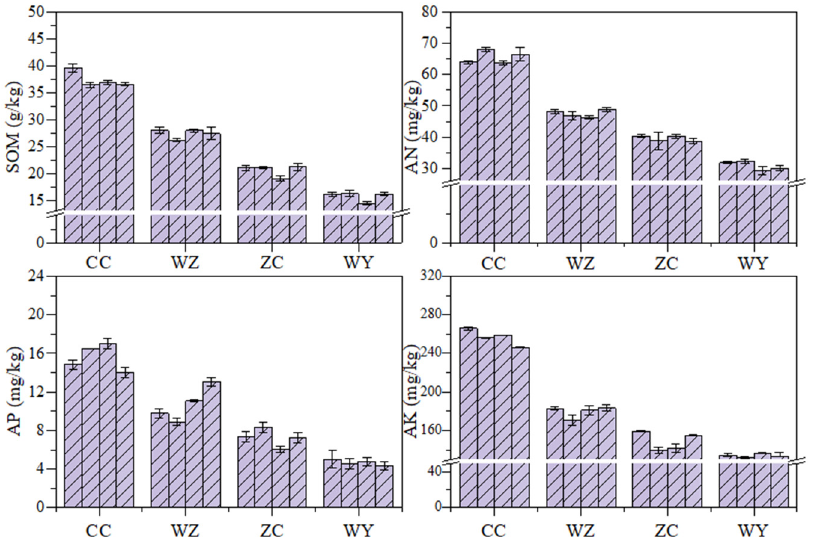
Figure 10. Chemical properties of coal gangue piles. SOM: soil organic matter; AN: total nitrogen; AP: available phosphorus; AK: available potassium.